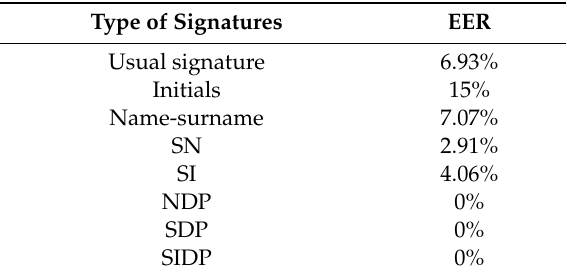
Figure 13. System performance on users of the lowest PE category considering the 8 signature types. Table 4. System performance on users of the lowest PE category in terms of EER.